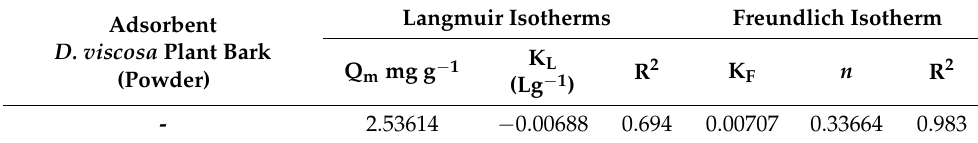
Table 2. Adsorption isotherm parameters for the adsorption of MR on D. viscosa plant bark.